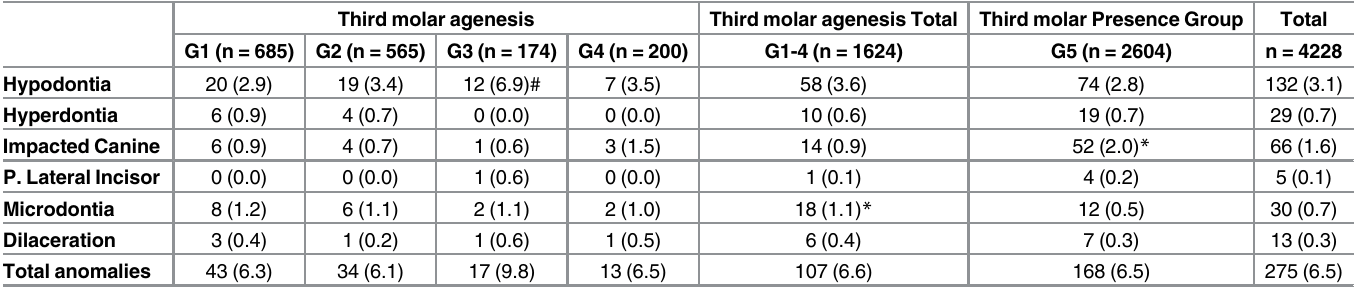
Table 3. Distribution and comparison of the other dental anomalies in subjects with or without third molar agenesis. Third molar agenesis Third molar agenesis Total Third molar Presence Group